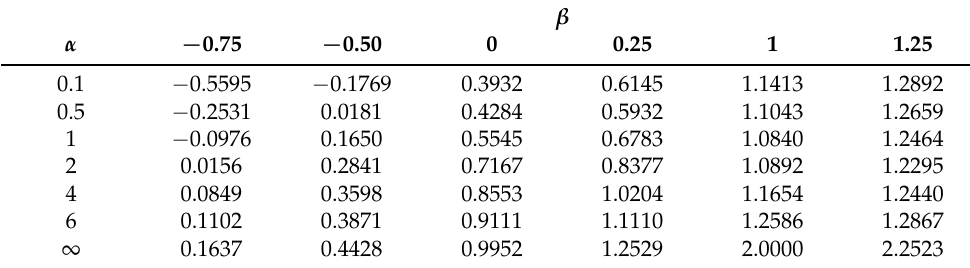
Table 1. Skewness coefficient in EHPE ( α ,1, β ) model for different values of α and β .